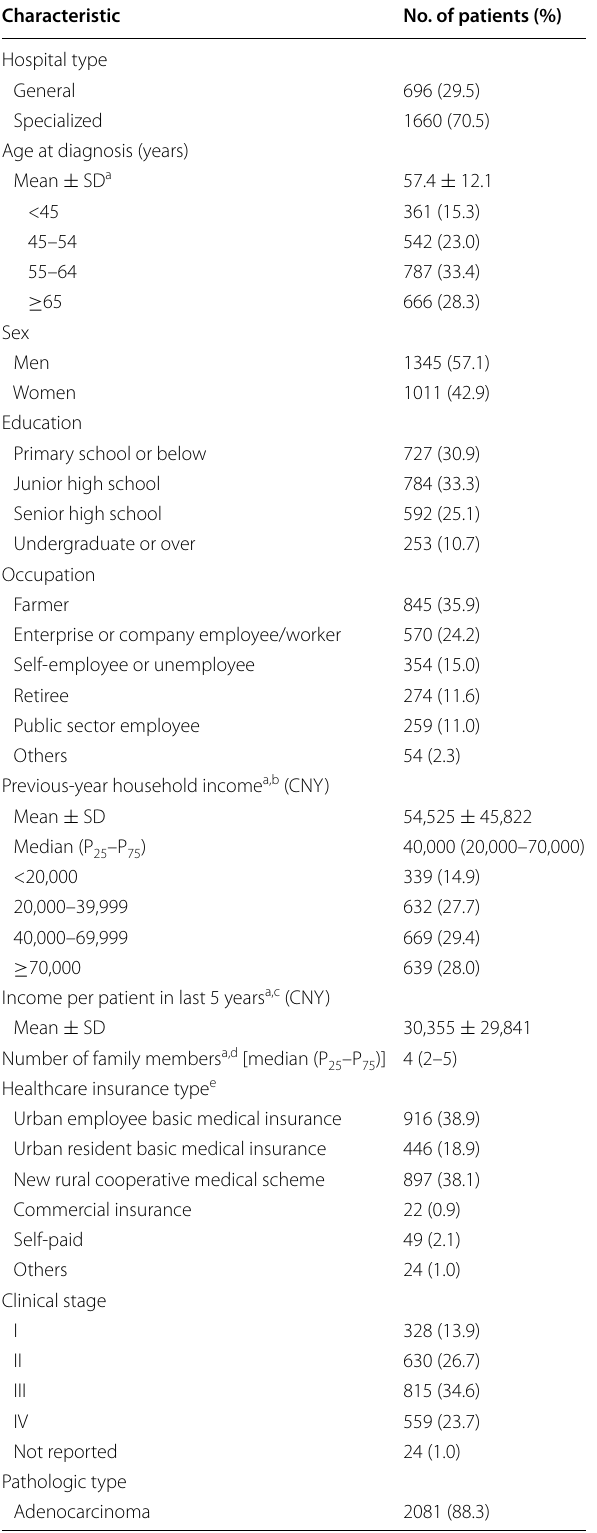
Table 2 Characteristics of 2356 patients with colorectal cancer